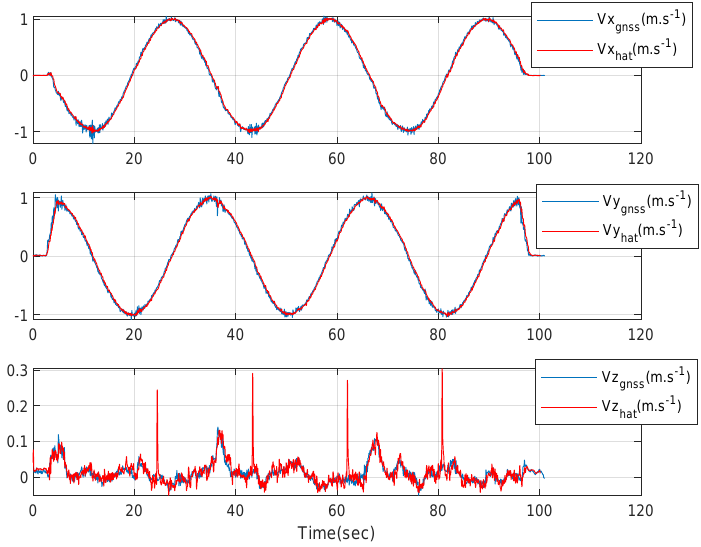
Figure 9. The 3-axis velocities of the rover: a circular driving test Second, the constant speed straight driving tests were performed. The rover’s speed is 2 m · s − 1 . Figures 10 and 11 show the planar trajectory of the straight driving rover and the expansion of the trajectory of the straight driving rover, respectively. The blue dots represent the measured GNSS trajectory and the red dots represent the trajectory estimated using the designed integration filter. Like the circular driving tests, the integration result is much smoother than the GNSS